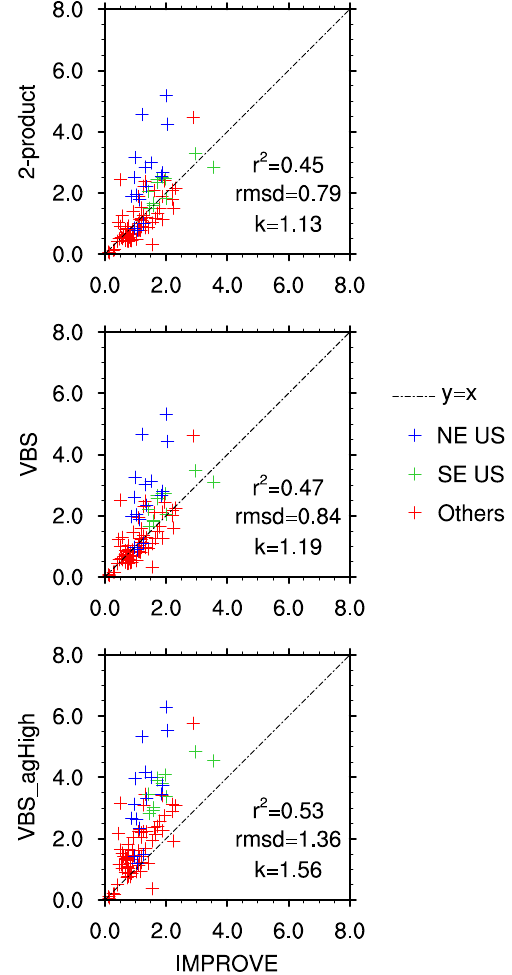
Figure 3. Comparison of averaged annual mean surface OC con- centrations (µg[C]m − 3 ) between IMPROVE measurements and the three simulations: 2-product, VBS and VBS_agHigh. Different col- ors indicate sites in different regions. In each subplot, the dashed line is the 1:1 line. The coefficients of determination ( r 2 ) , root- mean-square difference (rmsd) and the model-to-observation slope ( k ) are included.